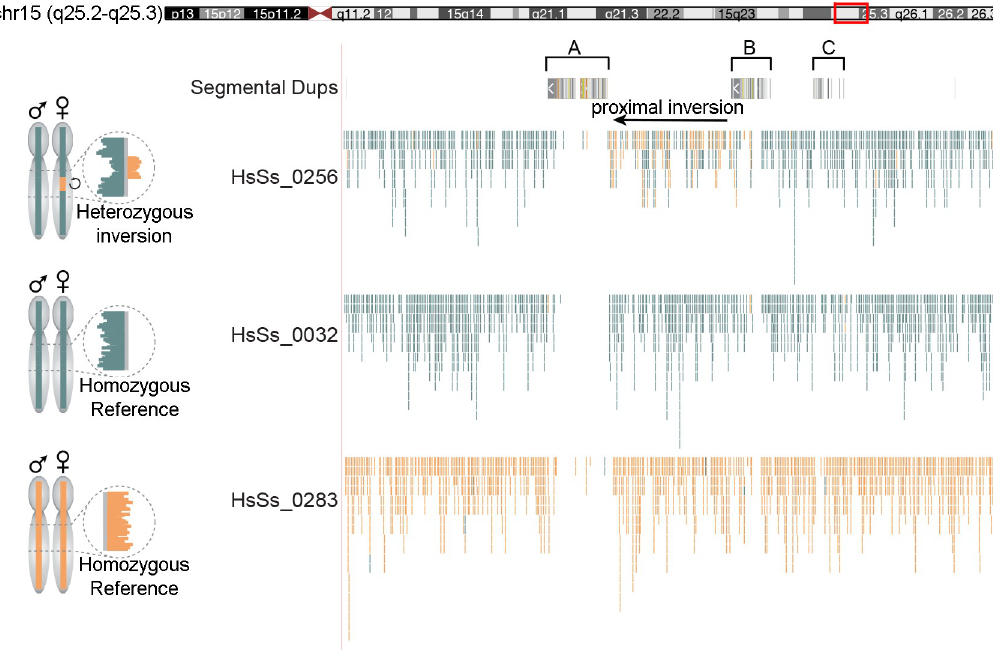
Fig 2. Strand-seq of the proximal inversion at 15q25. On the left, ideograms of expected Strand-seq results for each possible inversion genotype are shown. On the right, a UCSC Genome Browser view (coordinates lifted to GRCh37/hg19) of Strand-seq data, BED-formatted and uploaded as custom tracks, of the three libraries is shown. For each cell, aligned reads are indicated as individual lines in Crick (teal) or Watson (orange) state. In the library on the top (HsSs_0256) mixed Watson and Crick reads at the proximal inversion (black arrow) indicate the heterozygosity of the region while in the others a direct orientation of the region is shown.